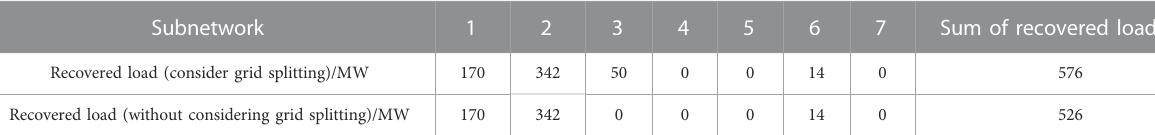
TABLE 6 Comparison of load recovery values.